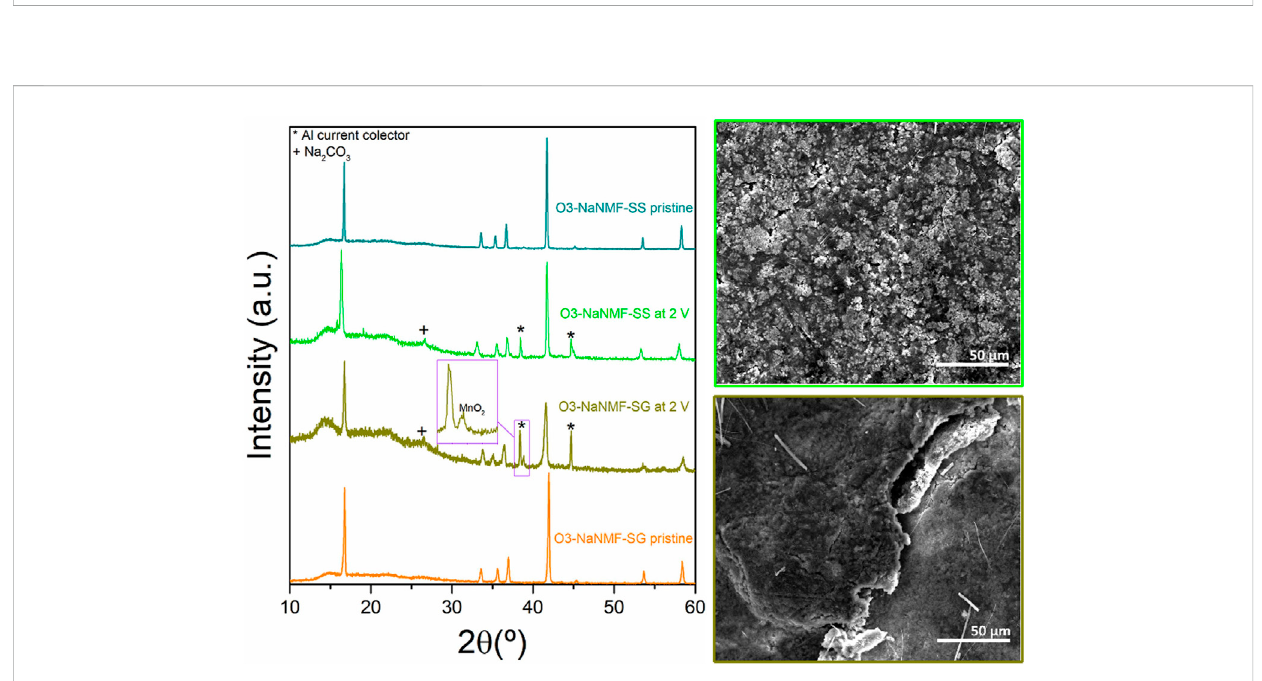
FIGURE 9 Ex-situ XRD patterns of O3-NaNMF-SS of O3-NaNMF-SG pristine electrodes as well as the cycled ones after 100 cycles at 2 V and their corresponding SEM images.